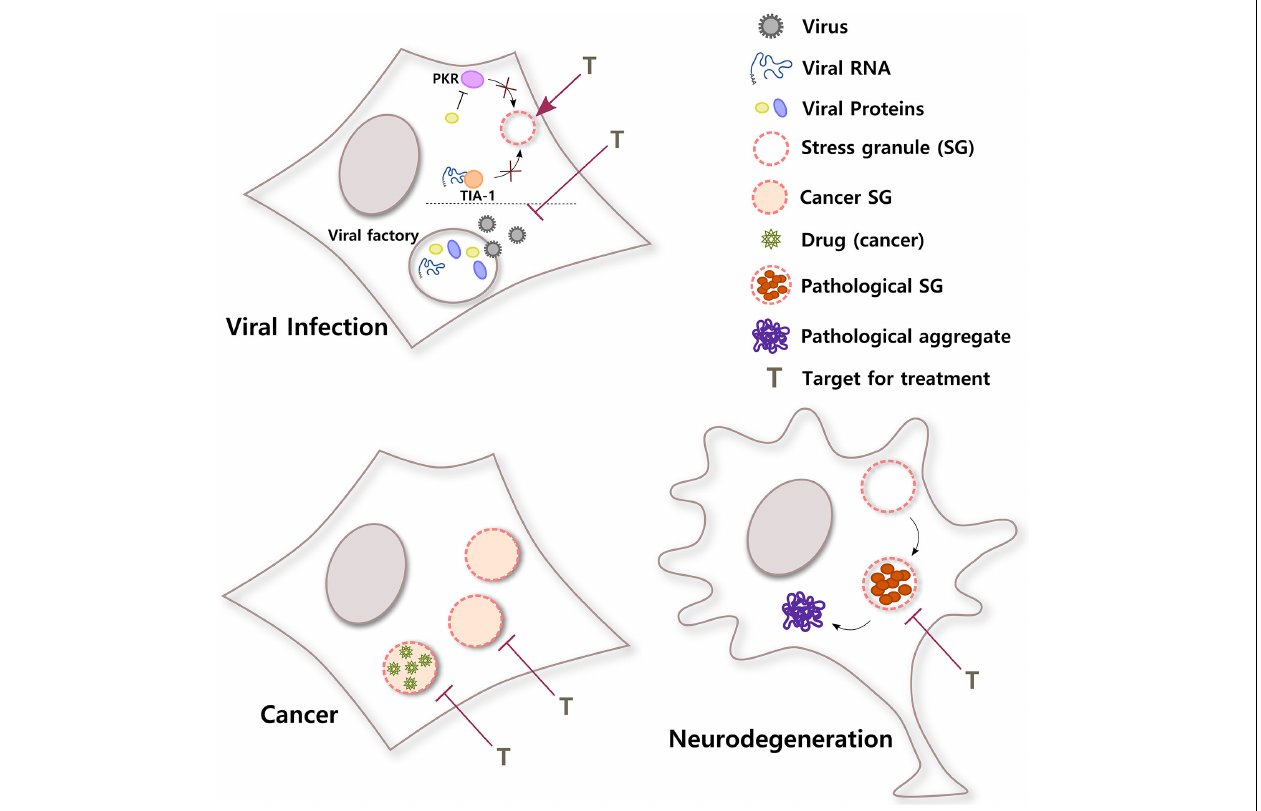
FIGURE 3 | SGs in different diseases. SGs have important roles in a broad variety of pathological stages. In viral infections, viruses use different strategies to counteract the antiviral response of SGs in the cell. For example, viral RNA can sequester T-cell-restricted intracellular antigen-1 (TIA-1) to inhibit SG formation or a viral protein can block PKR, a kinase that senses environmental stress. In addition, some viral factories, sites of replication, and packaging inside the cell have liquid organelle properties. Both protection of host SGs and destabilization of viral factories could be potential targets for viral infection. Conversely, cancer cells can induce selective translation of stress-adaptive mRNAs and SG formation to promote survival, chemoresistance, and metastasis. Interestingly, SGs also concentrate antineoplastic drugs, altering drug pharmacodynamics. Inhibiting the formation of SGs in cancer cells or the partitioning of cancer drugs into SGs might improve their efficacy. In neurodegenerative diseases such as ALS, chronic stress and/or mutations in SG proteins could induce the formation of rigid complexes in SGs, turning them into pathological structures that could be precursors of pathological aggregates. Treatments that selectively target pathological SGs might help to reduce the formation of irreversible toxic aggregates and improve neuronal